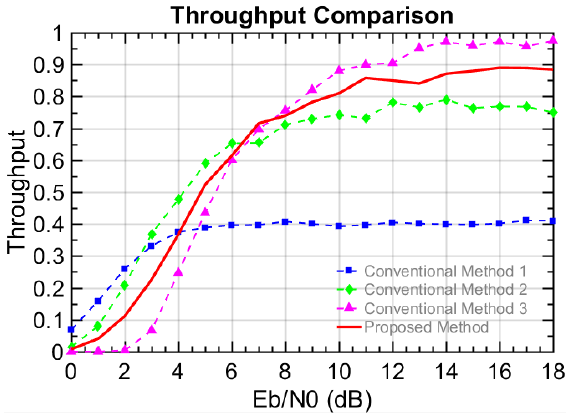
Figure 5. Throughput performance of V2V scenario I in a Rician fading channel with a constant K-factor value (10 dB).